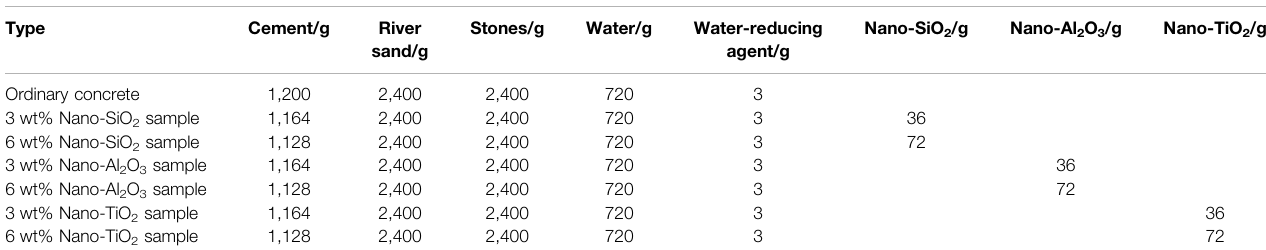
TABLE 2 | Concrete mixes.